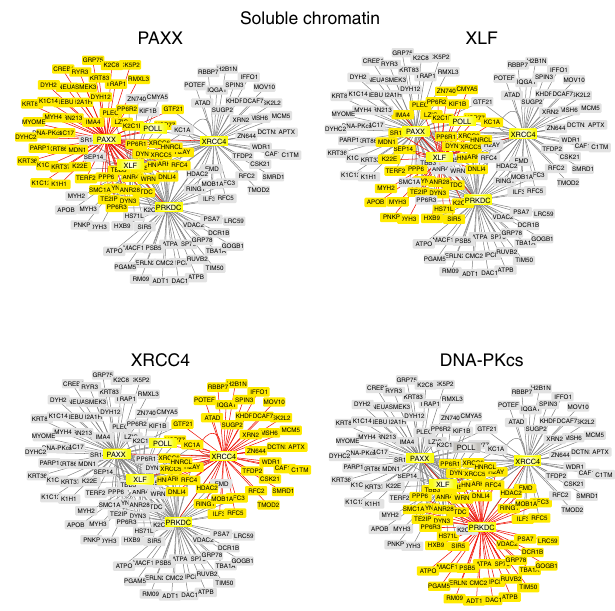
Fig. 1 Comparative Analysis of the Proteomes of XRCC4 Family Proteins isolated from Soluble Chromatin. Interactome analysis using FLAG-tagged PAXX, -XLF, -XRCC4 and -DNA-PKcs as bait from the benzonase-treated soluble chromatin fraction of HEK293F cells was performed using Cytoscape. Proteins highlighted by shaded yellow boxes indicate proteins which interact with the indicated bait protein e.g. PAXX, XLF, XRCC4 or DNA-PKcs. Shaded grey boxes depict proteins identi fi ed in combined proteomes of XRCC4 family proteins and DNA-PKcs